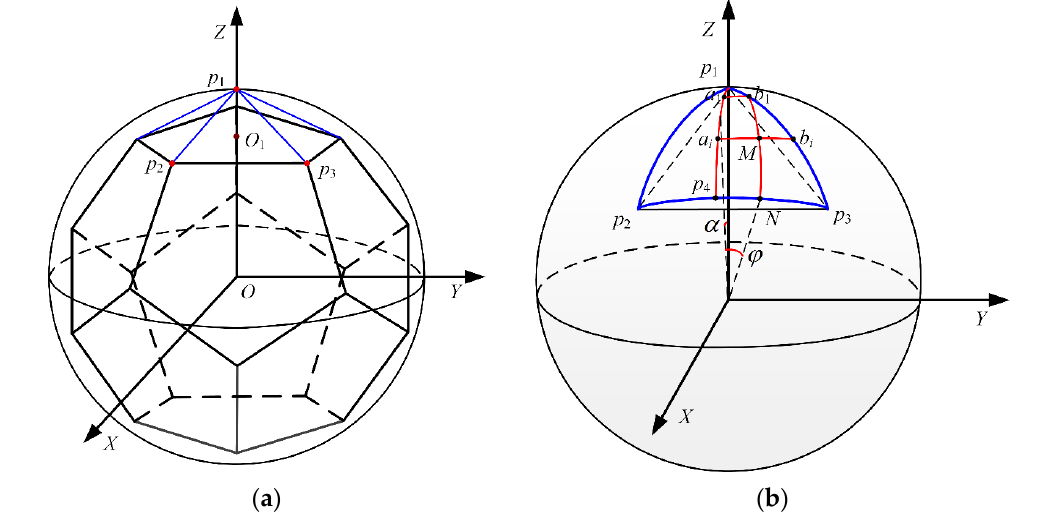
Figure 3. Spherical polygonal grid division: ( a ) the regular dodecahedron; ( b ) spherical triangle mapping.